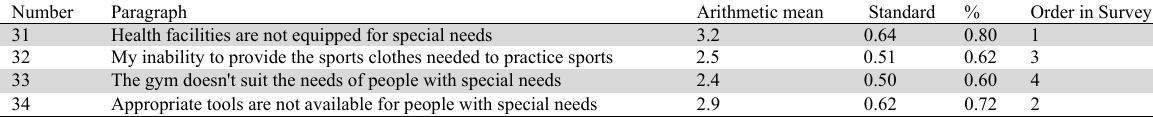
Arithmetic mean, SD and relative importance of the Tool's Fifth Field, Field of Material Capabilities Number Paragraph